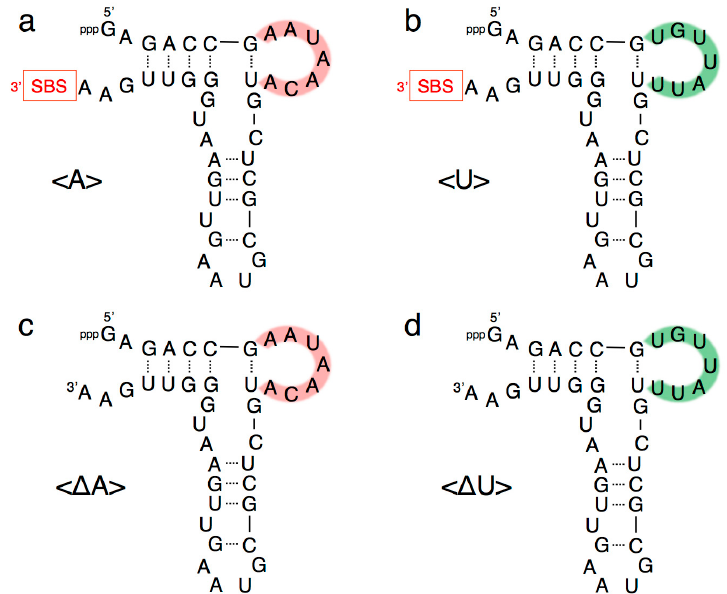
Figure 3. Composition of variants of R3C ligase ribozyme ( a ) <A>, ( b ) <U>, ( c ) < ∆ A>, and ( d ) < ∆ U> used in this study. Complementary seven-membered single stranded nucleotides (5 ′ -AAUAACA-3 ′ and 5 ′ -UGUUAUU-3 ′ ) are colored in pink and green, respectively. SBS, 3 ′ -terminal substrate-binding site.